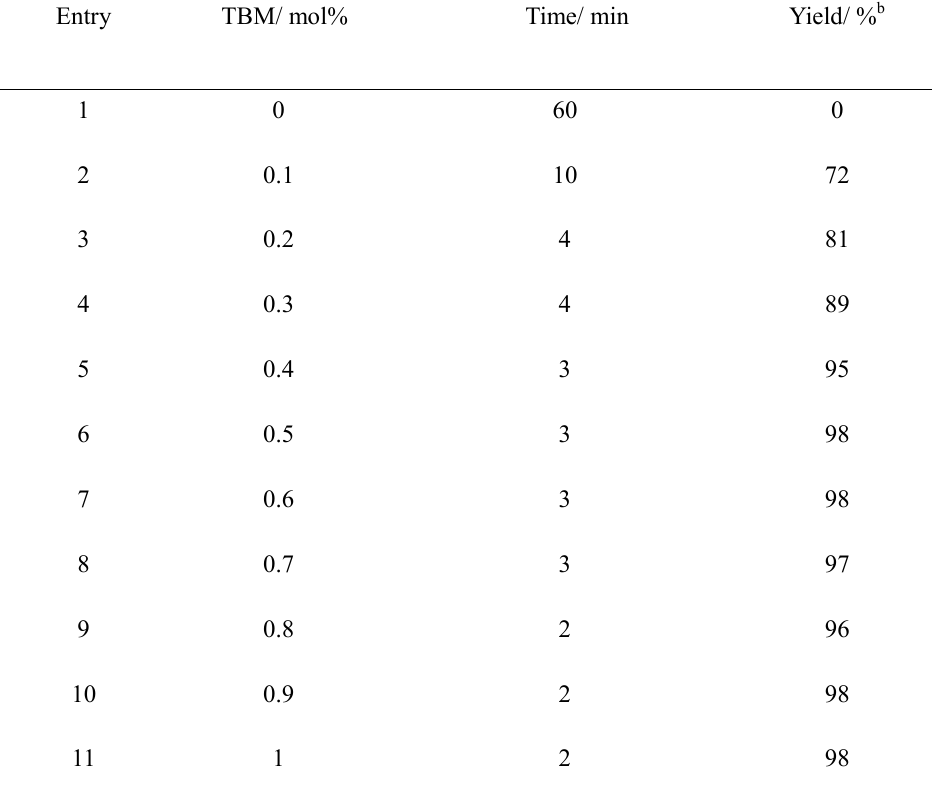
Table 2. The amounts of catalyst optimization for the synthesis of 2-phenylthiazoline a